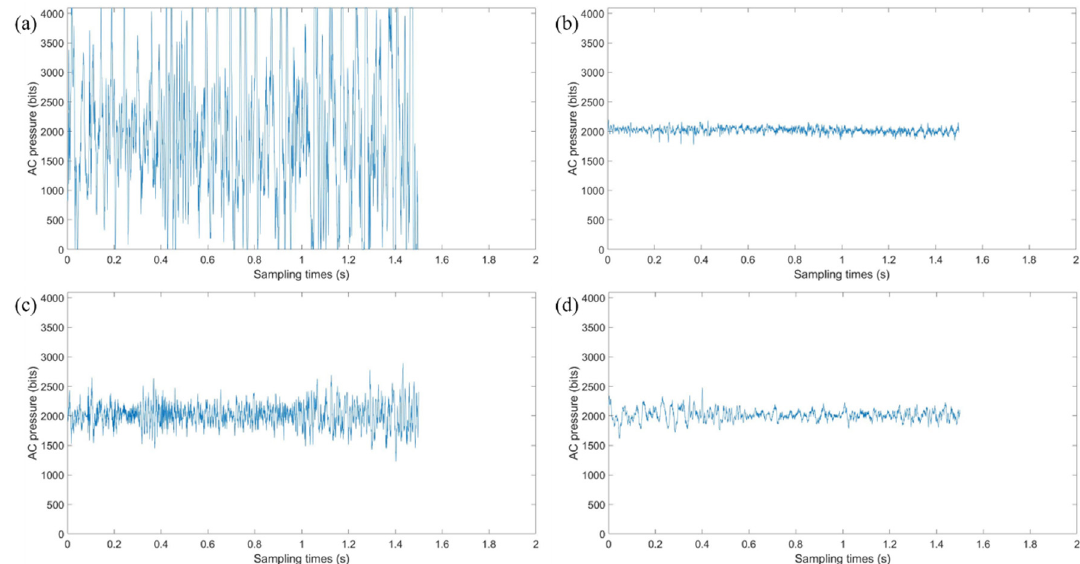
Figure 4. Vibration data of four materials: ( a ) polyester; ( b ) lambswool; ( c ) cotton linen; ( d ) foam.